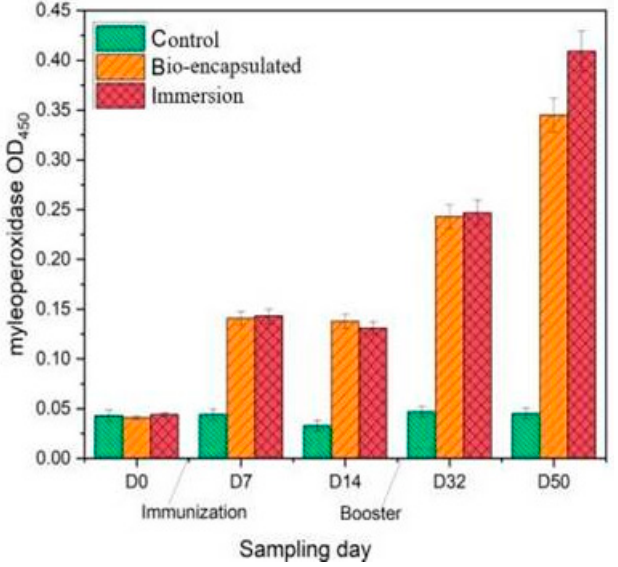
Figure 4. Serum myeloperoxidase (MPO) activity of the juvenile Cyprinus carpio L. in all three groups, control, bio-encapsulated and immersion at day 0, 7, 15, 32 and 50.